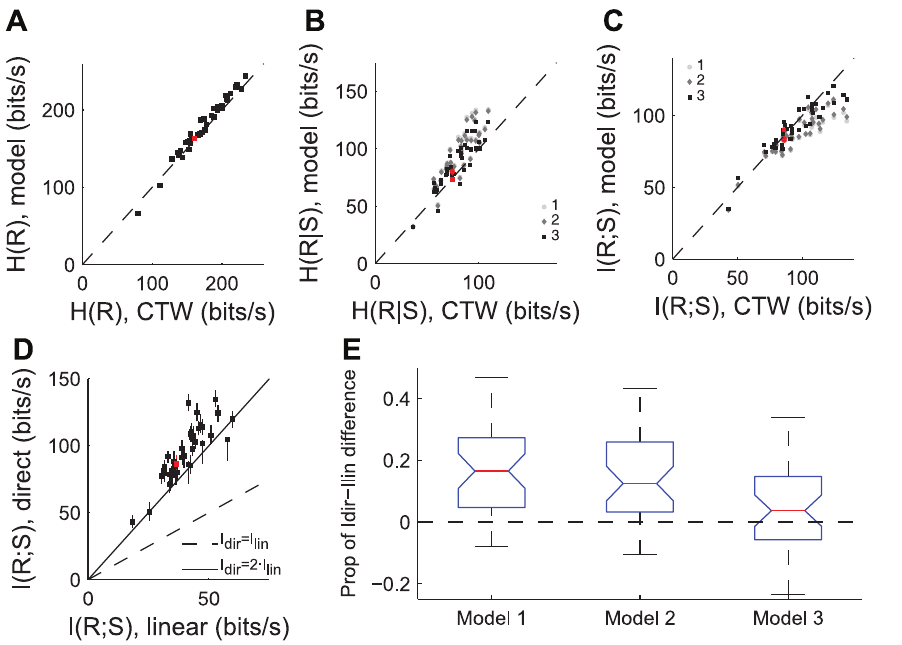
Figure 4. Comparison of information-theoretic quantities. A: Total response entropy rate for 40 neurons as measured using the context-tree- weighting (CTW) technique (x axis), vs. the modeled total response entropy (y axis). In panels A–D the red points indicate values from the cell in Figure 2, dashed black lines indicate unity between the x and y axes. B: Response entropy rate conditioned on a stimulus event as measured by CTW methods (x axis) vs models of the conditional entropy. C: Mutual information about the stimulus contained in the response patterns, calculated as the difference between total and conditional entropies of the response. X axis shows result of CTW estimation for each cell, y axis shows information calculation based on each of the three models. D: Comparison of mutual information measure using linear stimulus reconstruction approach (x axis) with estimation from CTW method. Solid black line indicates I dir =2 ? I lin E: Boxplot showing how much of the proportional difference of information between methodologies (I dir 2 I lin ) can be explained by varying temporal assumptions built in our models. For each of the three models, the boxplot shows the fraction of the information explained by the difference between that model and the direct method estimate from panel D, i.e. prop(x)=(I